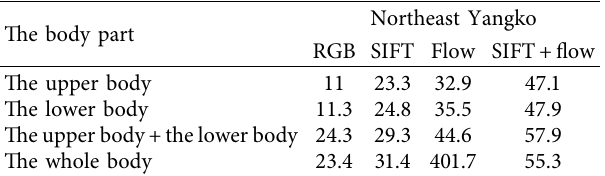
Table 2: Recognition effects of different features extracted from different human body regions.